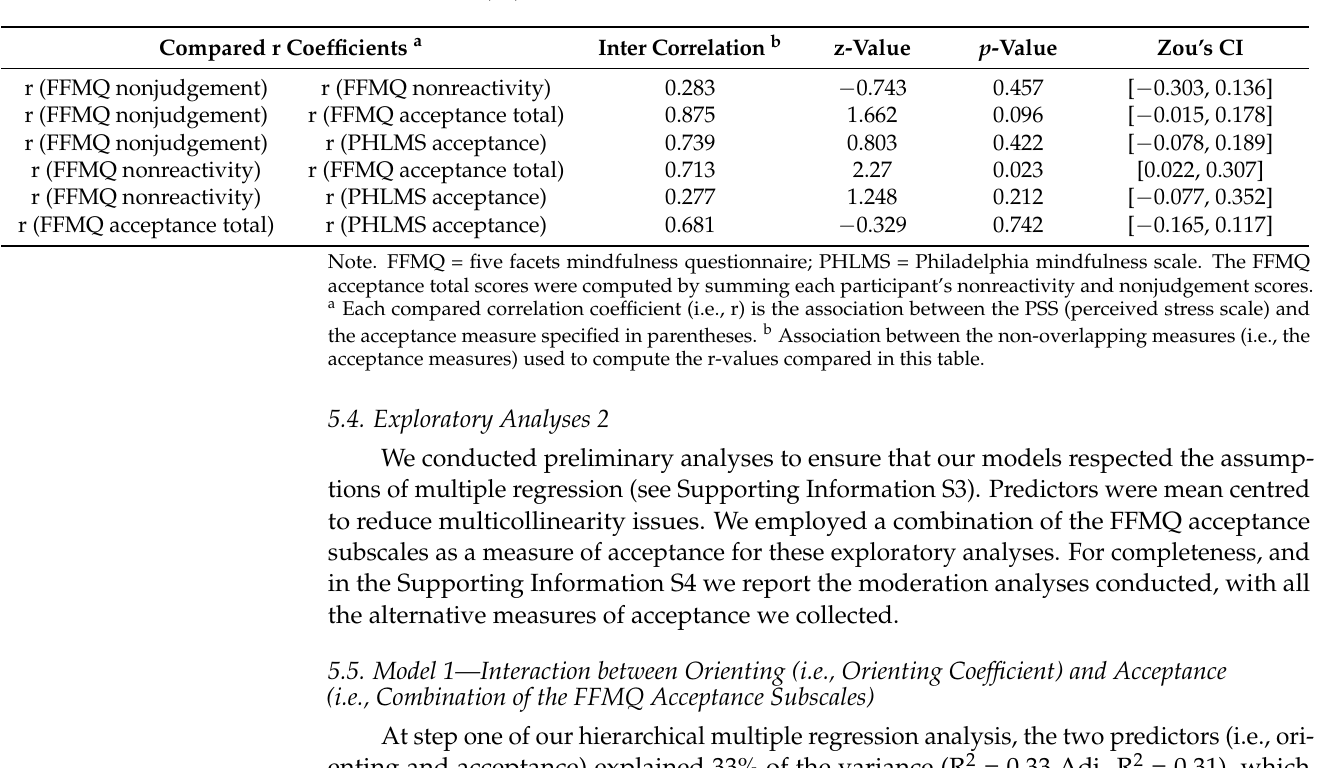
Table 4. Comparison of the correlation coefficients, including Dunn and Clark’s z and Zou’s confi- dence intervals (CI).